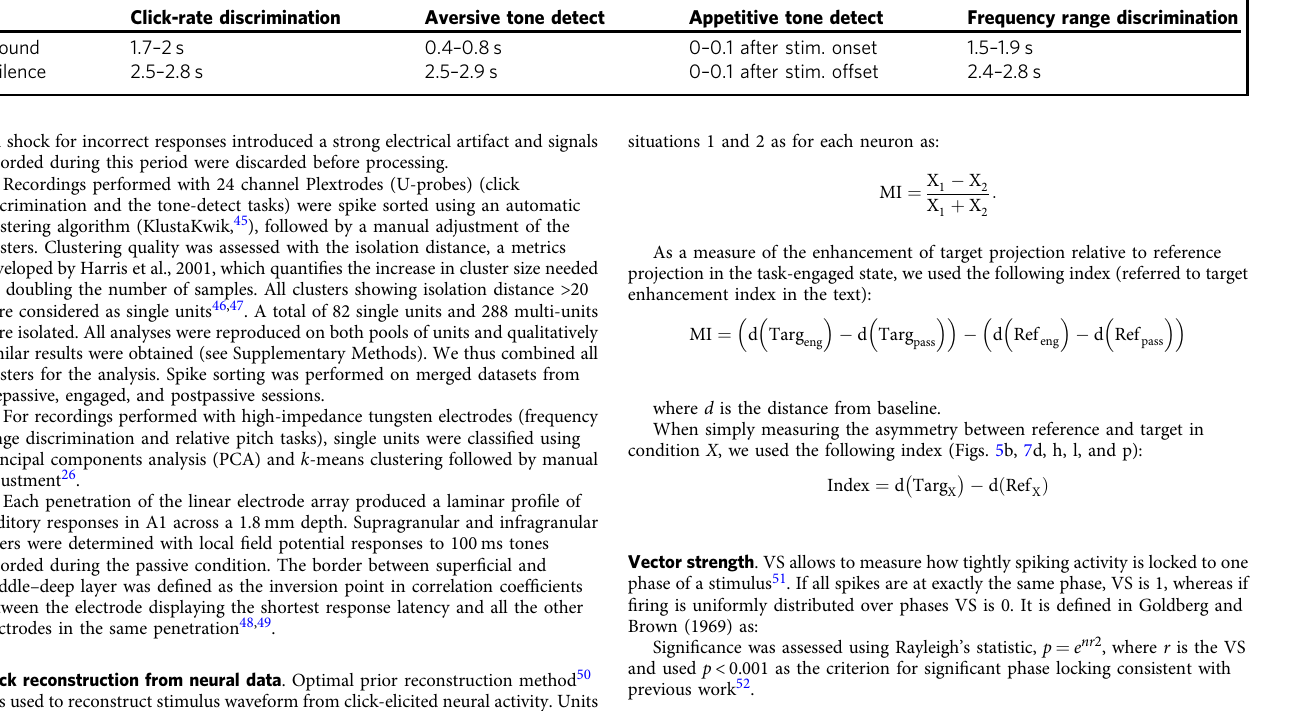
Table 2 Summary of time periods used for decoding across behavioral